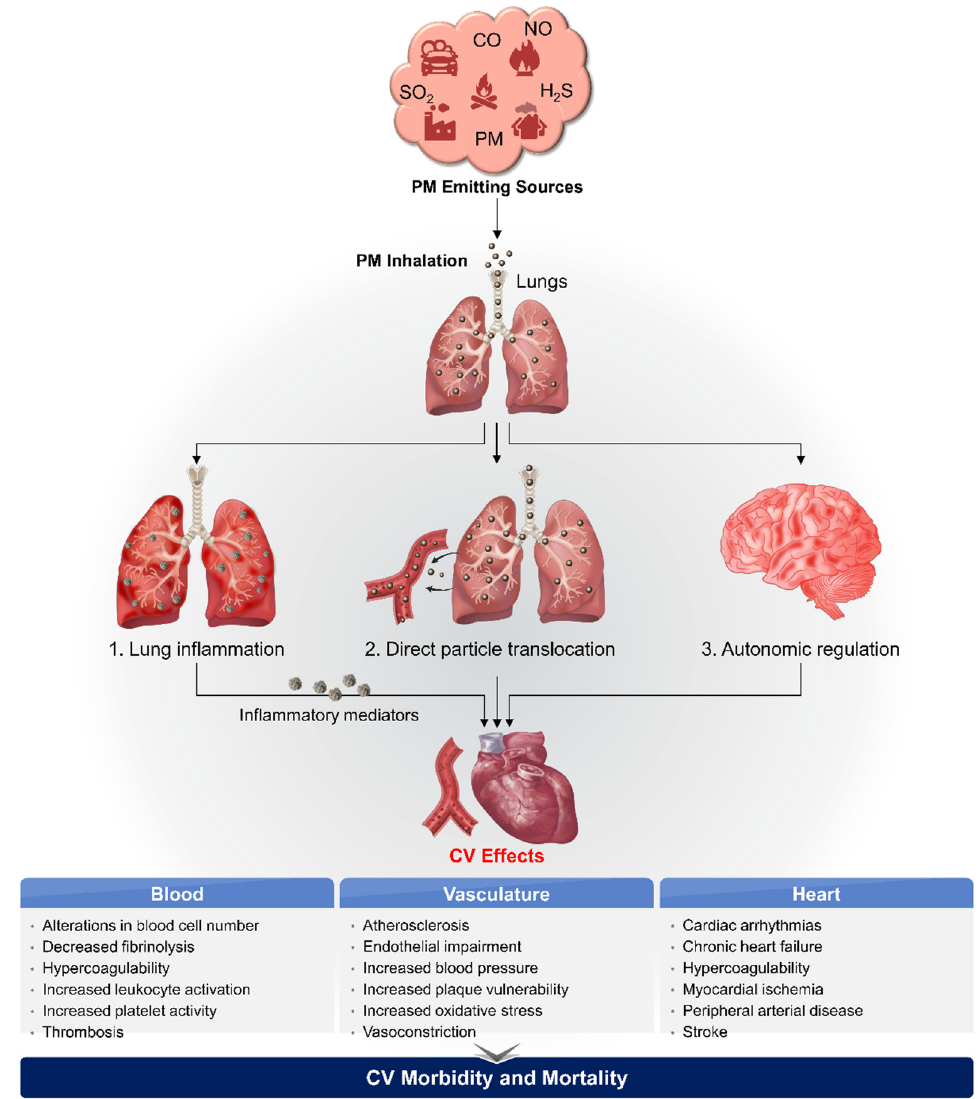
Figure 1. Biological pathways associated with particulate matter (PM) and cardiovascular disease (CVD). Primary signaling pathways through which inhaled PM can induce the incidence of cardiovascular events, eventually leading to cardiovascular morbidity and mortality. Adapted from Ref. [5] .